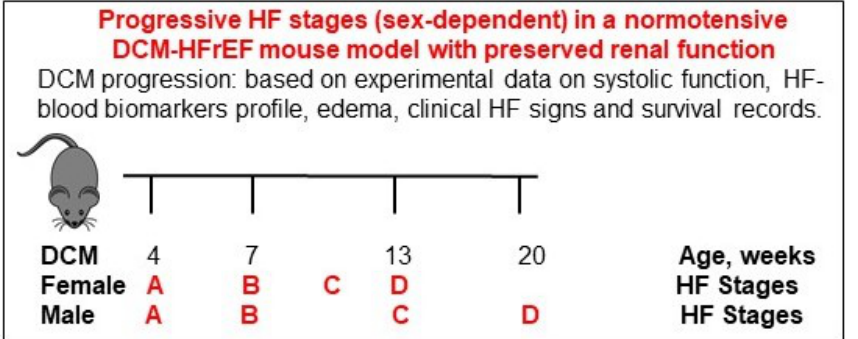
Figure 2. Schematic presentation of established progressive mouse model of dilated cardiomyopa- thy heart failure with reduced ejection fraction (DCM-HFrEF).